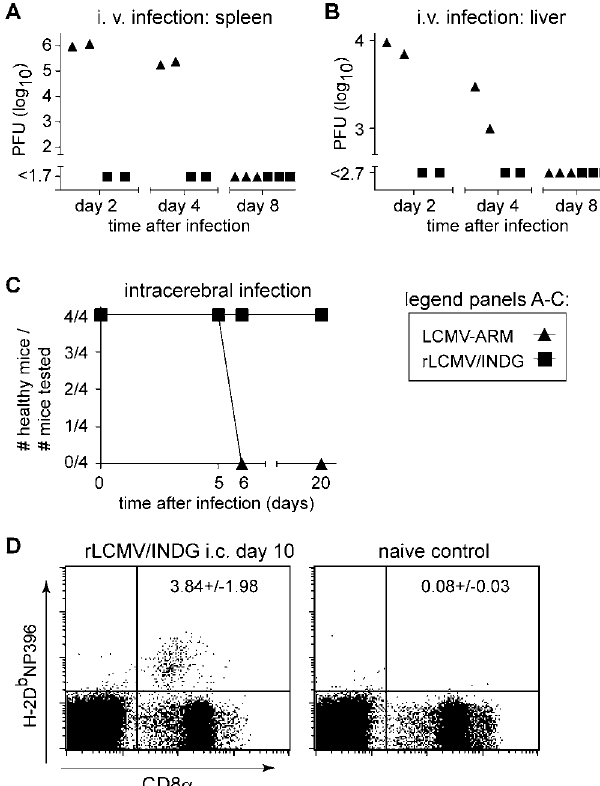
Figure 2. Attenuation of rLCMV/INDG Prevents Lethal Disease in Infected Mice (A, B) C57BL/6 mice were infected i.v. with 2 3 10 4 PFU of either rLCMV/ INDG or LCMV-ARM. At the indicated time points after inoculation, groups of two or three mice were killed and viral titers in spleen (A) and liver (B) were determined by immunofocus assay. Symbols represent individual mice. (C) C57BL/6 mice (four per group) were infected with 3 3 10 3 PFU rLCMV/ INDG or LCMV-ARM i.c. At the time points indicated, they were monitored for clinical signs of choriomeningitis. Animals with terminal disease were killed according to the Swiss law for animal protection. (D) Mice were infected with 3 3 10 3 PFU rLCMV/INDG i.c. Ten days later, NP396-specific CD8 þ T cells in peripheral blood were enumerated using MHC class I tetramers. Numbers in the upper right quadrants indicate the percentage of NP396-specific CD8 þ T cells within the total CD8 þ T cell population. Each panel (A–D) shows the results from one representative experiment of two similar ones.